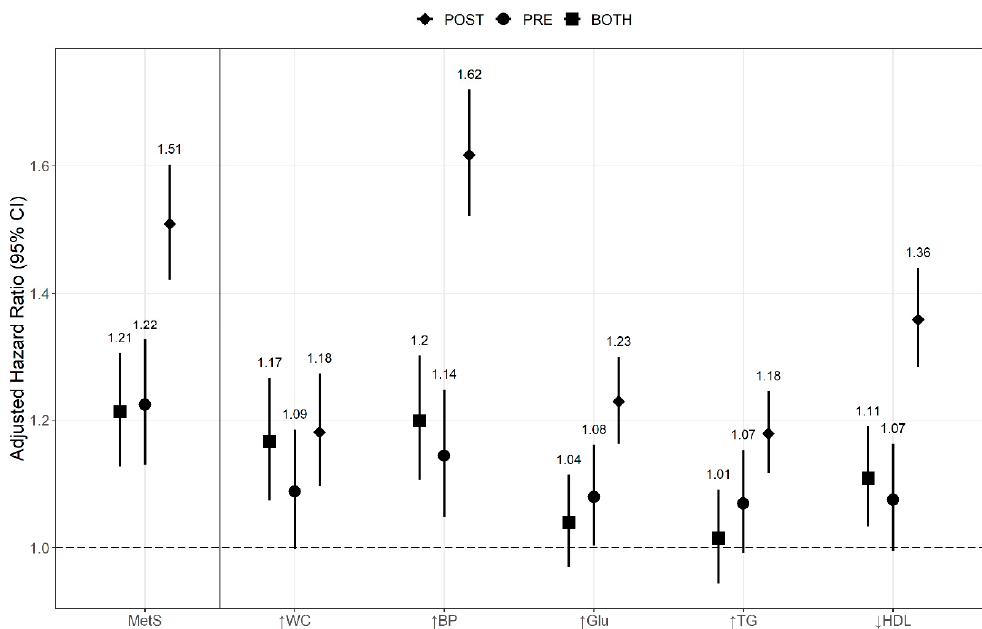
Figure 4. Hazard ratios for the risk of kidney cancer by recovery from MetS and its components. The Cox proportional hazard regression model was adjusted for age, sex, smoking status, alcohol consumption, body mass index, and regular physical exercise. Abbreviation: CI, confidence interval; ↑ WC, abdominal obesity; ↑ BP, hypertension; ↑ Glu, impaired glucose tolerance; ↑ TG, hypertriglyceridemia; ↓ HDL, decreased HDL-cholesterol; MetS, metabolic syndrome.